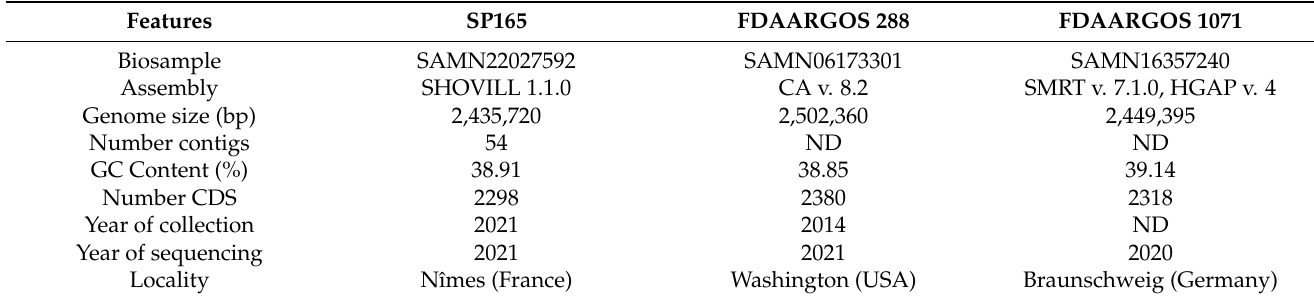
Table 1. General characteristics of S. pettenkoferi SP165 strain.